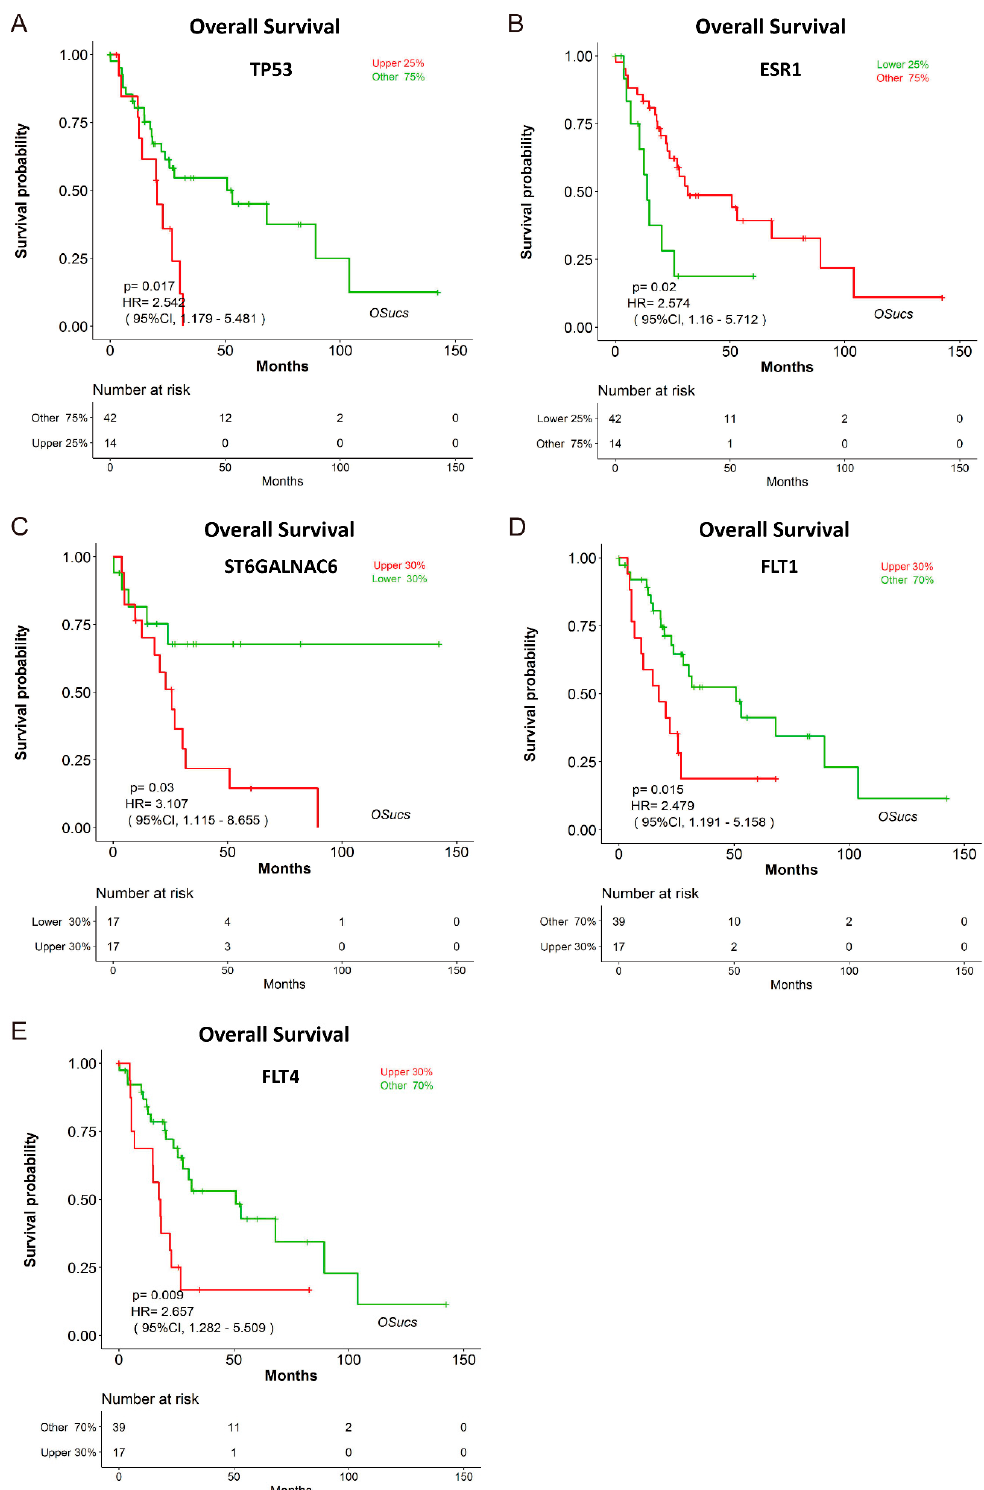
Figure 3. Validation of previous reported prognostic biomarkers in OSucs. Kaplan-Meier plots for ( A ) TP53, ( B ) ESR1, ( C ) ST6GALNAC6, ( D ) FLT1 and ( E ) FLT4 (OS).